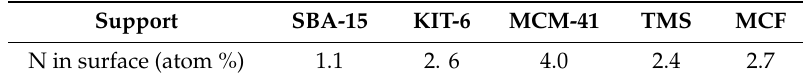
Table 3. Atom % nickel in the surface of reduced Ni catalysts with di ff erent supports as determined by by XPS.